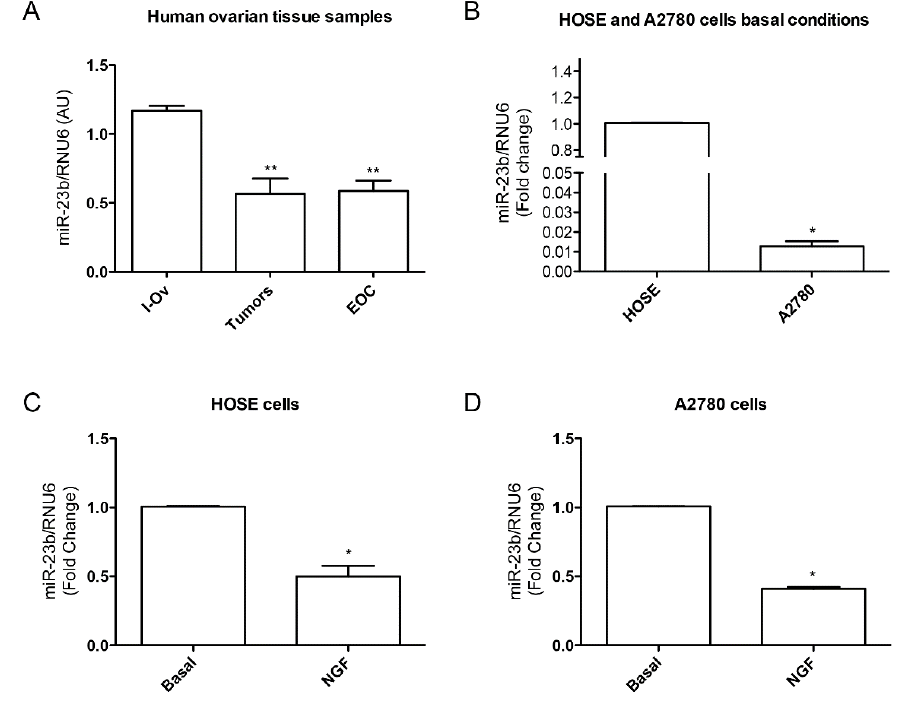
Figure 3. miR-23b levels in epithelial ovarian cancer and its relationship with NGF in cell lines. ( A ) miR-23b levels in tissues from inactive ovary (I-Ov), tumor and EOC samples. miR-23b levels from tumor and EOC samples are significantly lower than I-Ov (** = p < 0.01); ( B ) miR-23b basal level comparision between HOSE and A2780 cell lines (* = p < 0.05); ( C ) NGF effect on miR-23b levels in HOSE cell line. NGF reduces miR-23b levels respect to basal condition (* = p < 0.05); ( D ) NGF effect on miR-23b levels in A2780 cell line. NGF reduces miR-23b levels respect to basal condition (* = p <